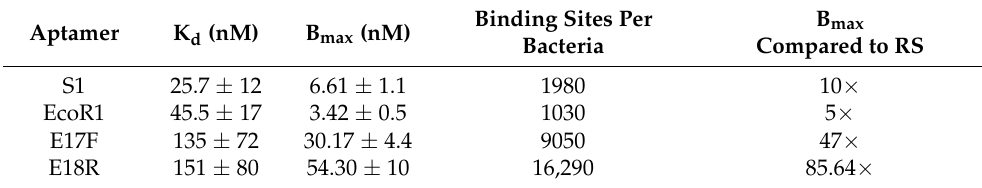
Figure 2. Binding isotherms for aptamers and random sequence (RS) with E. coli O157:H7. Table 2. Measured dissociation constant (K d ) and binding capacity (B max ) values for the four selected aptamers for E. coli O157:H7 and their comparison with the B max of the RS. Data represent Mean ± SD of 3 independent